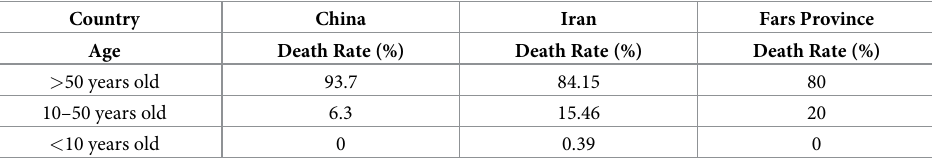
Table 1. Comparison of age in death cases of China, Iran, and Fars